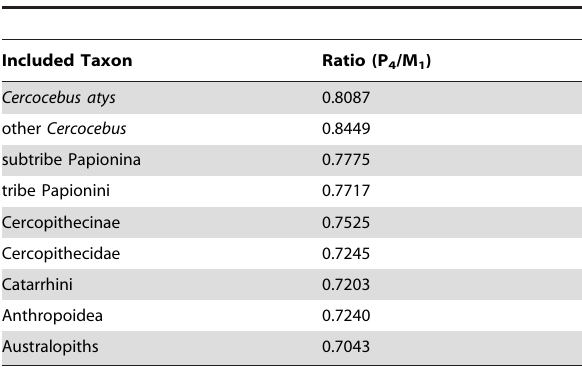
Table 1. Mean Ratio of P 4 /M 1 area in Cercocebus atys and Higher